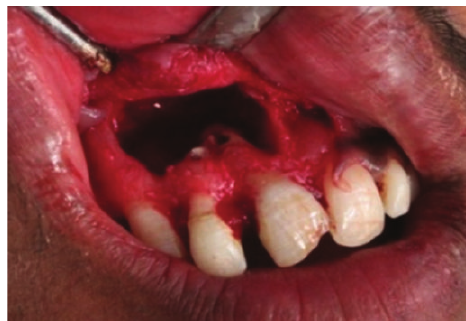
Figure 36: Apicoectomy.